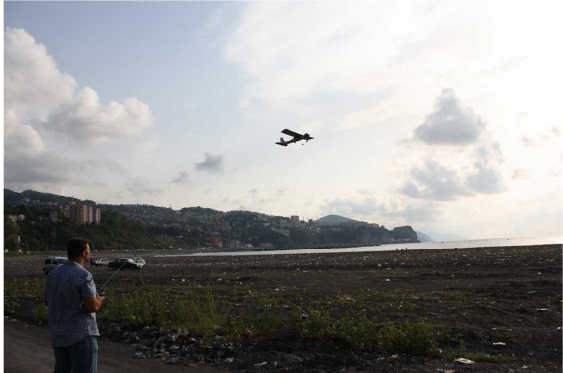
Figure 3 Model Aircraft Soon After Take Off